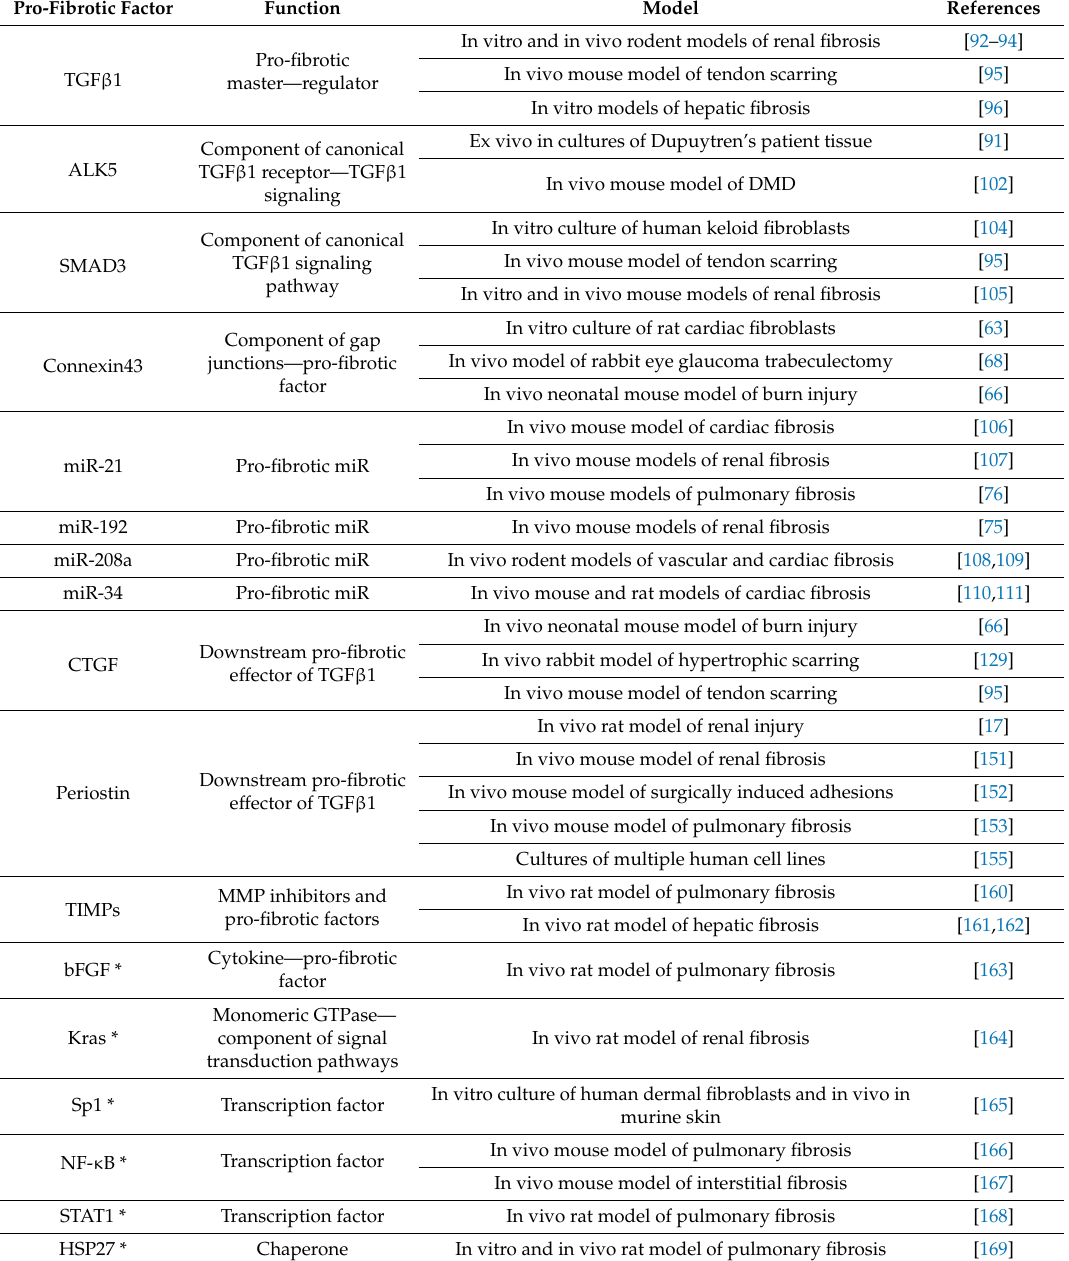
Table 1. Summary of profibrotic factors that have been targeted with